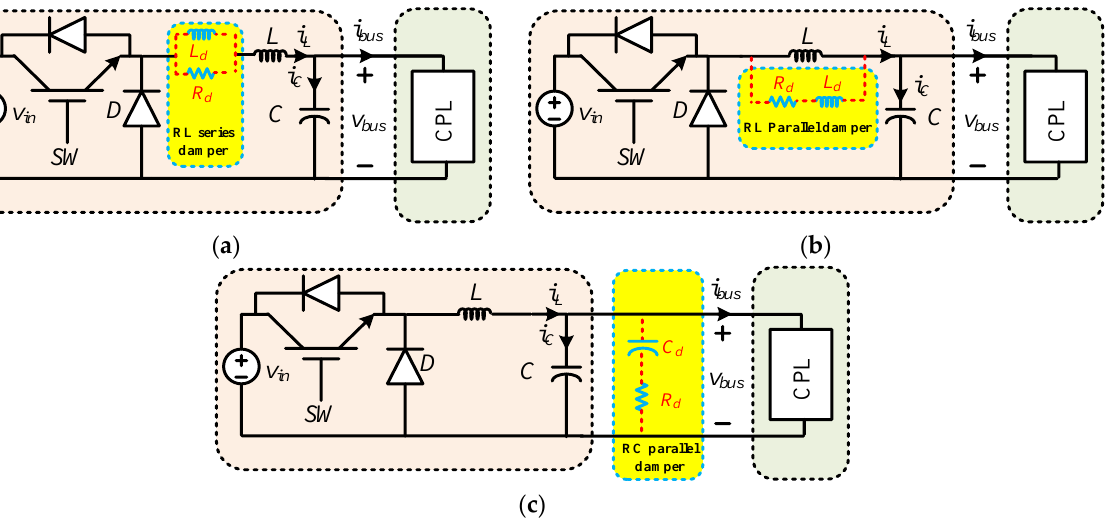
Figure 8. Passive damping stabilization techniques: ( a ) RL series damper; ( b ) RL parallel damper; ( c ) RC parallel damper [77].